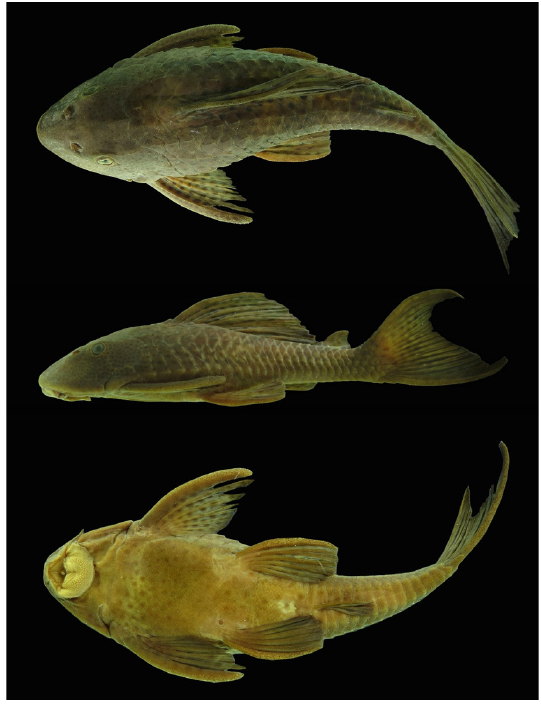
FIGURE 10 | Hypostomus aff. pusarum , UFPB 11077, 164.5 mm SL, Ingazeiro reservoir, Paulistana, Piauí, Brazil.